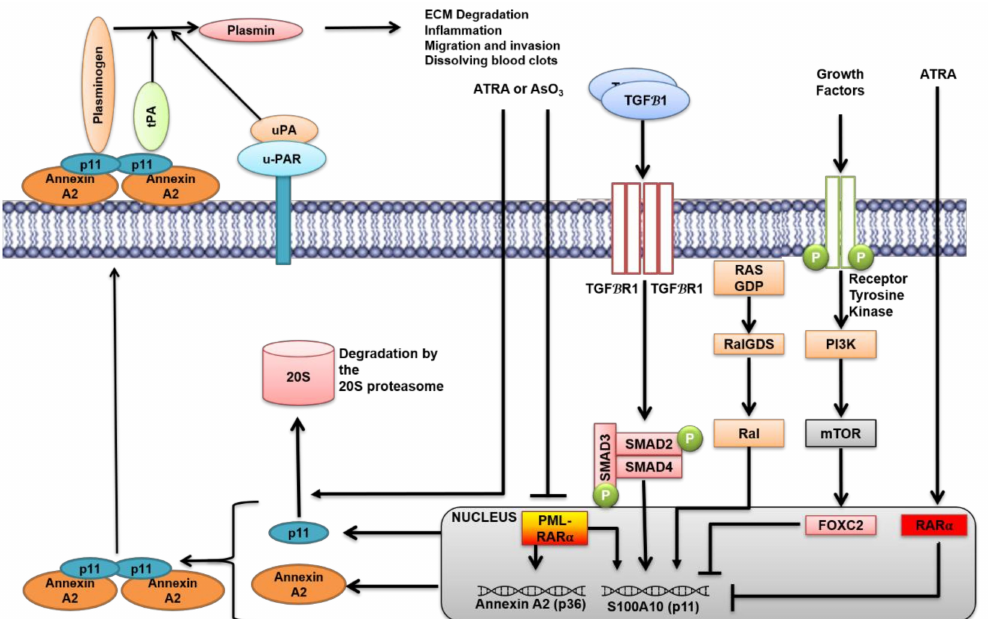
Figure 2. Regulation of S100A10 (p11): P11 is transactivated by (1) the promyelocytic leukemia-retinoic acid receptor alpha (PML-RAR α ) fusion oncoprotein, (2) TGF β 1-dependent activation of the SMAD pathway, and (3) oncogenic RAS-mediated activation of the Ral-GDS/Ral pathway. Conversely, transcriptional repression of P11 is mediated by (1) ATRA- and arsenic trioxide (AsO3)-induced degradation of the PML-RAR α fusion oncoprotein, (2) growth factor-induction of the PI3K/mTOR pathway and consequent FOXC2-dependent transcriptional repression of p11, and (3) ATRA-activation of RAR α . Newly transcribed p11 and p36 (Annexin A2) proteins rapidly form the AIIt heterotetramer complex within the cytoplasm prior to being transported to the cell surface. Although the p11–p36 interaction protects p11 from degradation by the 26S proteasome, ATRA and AsO3 both induced the ubiquitin-independent degradation of p11 by the 20S proteasome. Once at the cell surface, AIIt acts as a dual receptor for plasminogen and tissue plasminogen activator (tPA) and co-localizes with and urokinase-type-plasminogen activator/uPAR complex. By localizing plasminogen and its activators, AIIt catalyzes the cleavage of plasminogen to produce plasmin, a serine protease involved in ECM degradation, inflammation, cellular migration an invasion, and blood clot